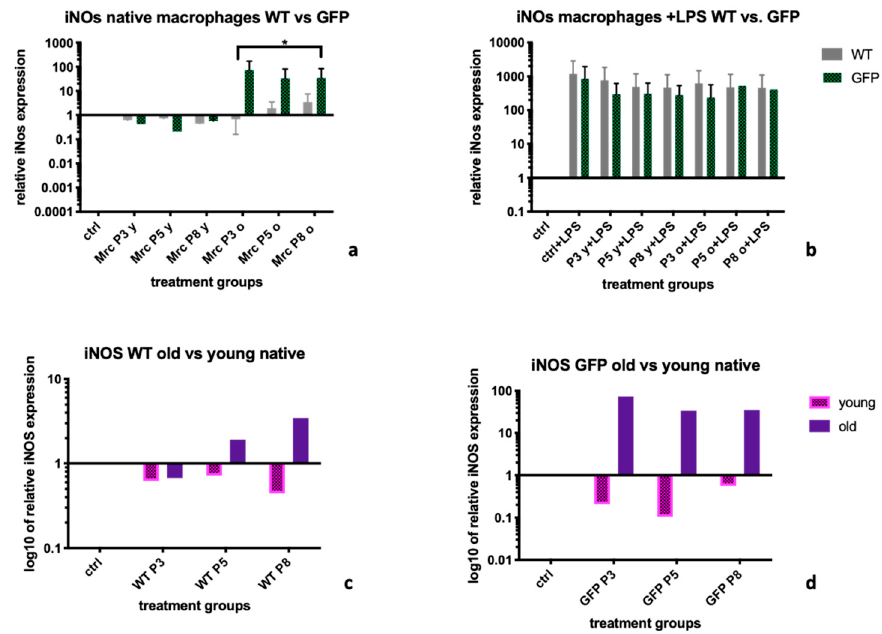
Figure 2. iNOS expression levels in BMDM after treatment with MSC-wildtype versus MSC-GFP+ supernatants of different age groups and passages. The graph shows the influence of different MSC supernatants on the expression levels of Inducible Nitric Oxide Synthase (iNOS) on BMDM coming from a WKY-wt rat. Supernatants from MSCs extracted from MSC-wt donors led to lower iNOs expression levels than supernatants from MSC-GFP+ cells. Furthermore, within supernatants from older donors, this difference was significant ( a ). After LPS stimulation of BMDM, supernatants from GFP+ cells and supernatants from WT cells had similar effects on BMDMs in culture ( b ). Within supernatants from both, MSC-wt and MSC-GFP+ supernatants, young groups inhibited expression of iNOS more efficiently in native BMDM than supernatants from MSCs extracted from old donors, however without statistical significance ( c , d ). Statistical evaluation: Mann-Whitney U test. mRNA levels were calculated using RT-PCR and the ΔΔ Ct-method. Untreated macrophages served as control and HPRT-1 was the housekeeping gene. Statistical significance: no statistical significance (ns; no asterisk); p < 0.05 (*). BMDM = bone marrow derived macrophages, iNOS = Inducible Nitric Oxide Synthase , WT= supernatants coming from wild-type cells, GFP = supernatants from GFP+ cells. Old = supernatants from cells from donor rats >6 months of age, young = supernatants from cells from donor rats < 6 months of age.